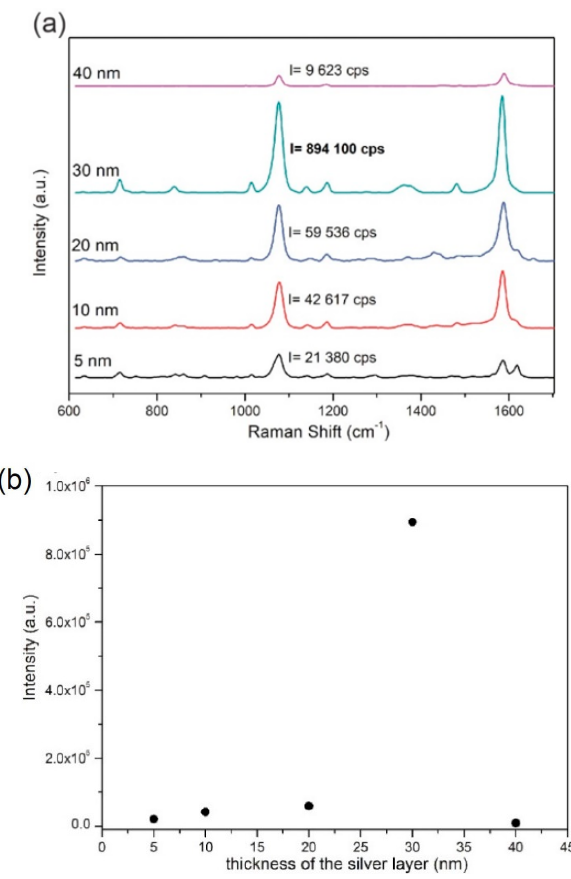
Figure 5. SERS spectra of para -mercaptobenzoic acid ( p -MBA) (10 − 6 M) on PET/ITO/Ag platforms with various silver thicknesses. ( a ) Intensity of a band at 1075 cm − 1 in relation to sputtered silver thickness. ( b ) SERS spectra were recorded using a 785 nm laser excitation (the laser power was below 5 mW) with three accumulations for four seconds.